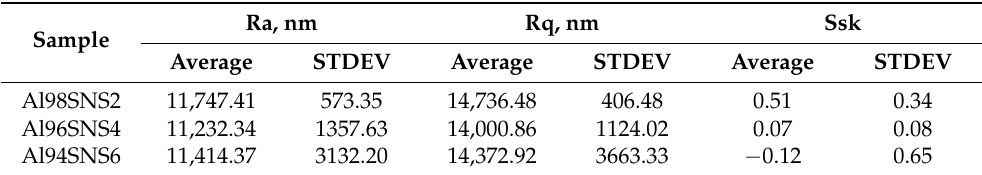
Table 9. Roughness results after corrosion (averaged values of 10 profiles on each investigated sam- ple).